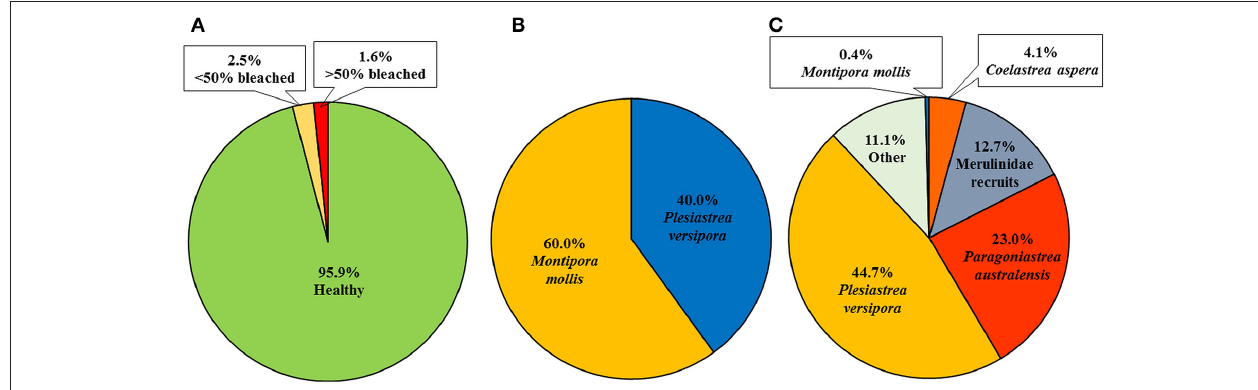
FIGURE 4 | Summary of coral colonies within long term growth plots in Marmion Marine Park as surveyed in January, 2017. (A) Proportion of coral colonies healthy, < 50% bleached and > 50% bleached, (B) species breakdown of the bleached corals, and (C) healthy corals.